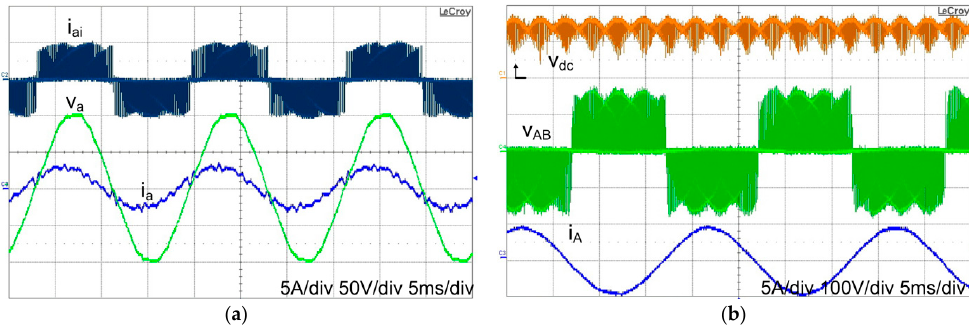
Energies 2017 , 10 , 588 11 of 13 Figure 12. Experimental setup for the IMC topology. Figure 12. Experimental setup for the IMC topology.